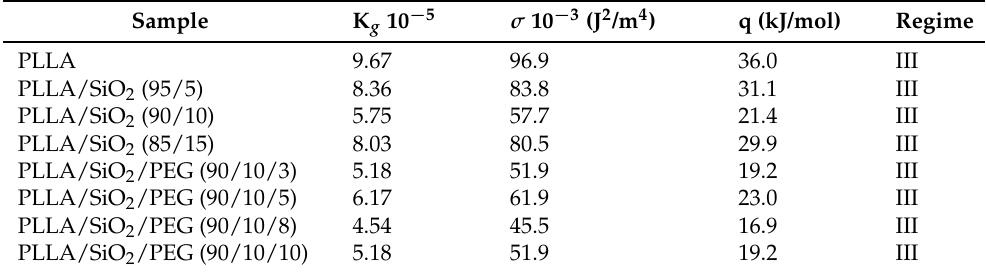
Table 7. Kinetics parameters for PLLA and the composites obtained by the HL model (Equation (4)). Sample K g 10 − 5 Regime